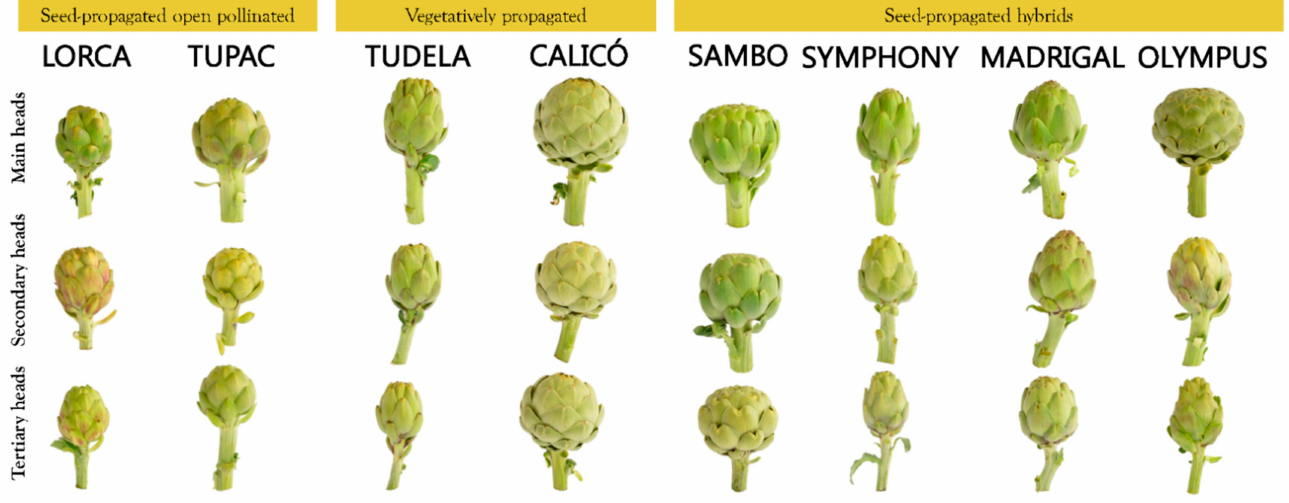
Figure 1. Main, secondary, and tertiary heads of seed-propagated open-pollinated cultivars (‘Lorca’ and ‘Tupac’), veg- etatively propagated cultivars (‘Blanca de Tudela’ and ‘Calic ó ’), and seed-propagated hybrids (‘Sambo’, ‘Symphony’, ‘Madrigal’, and